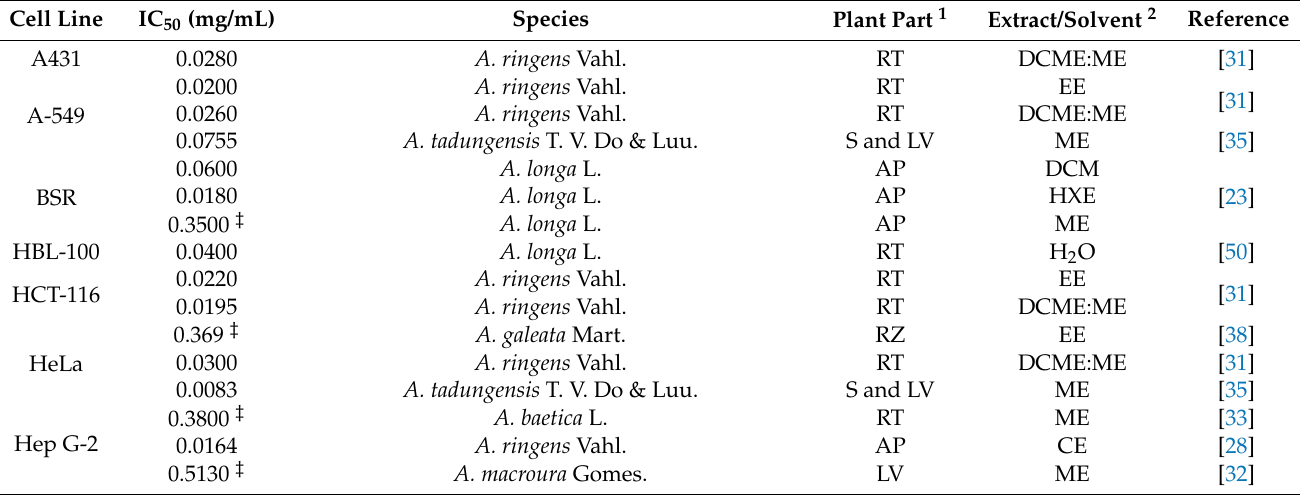
Table 3. IC 50 values of crude extracts of the genus Aristolochia